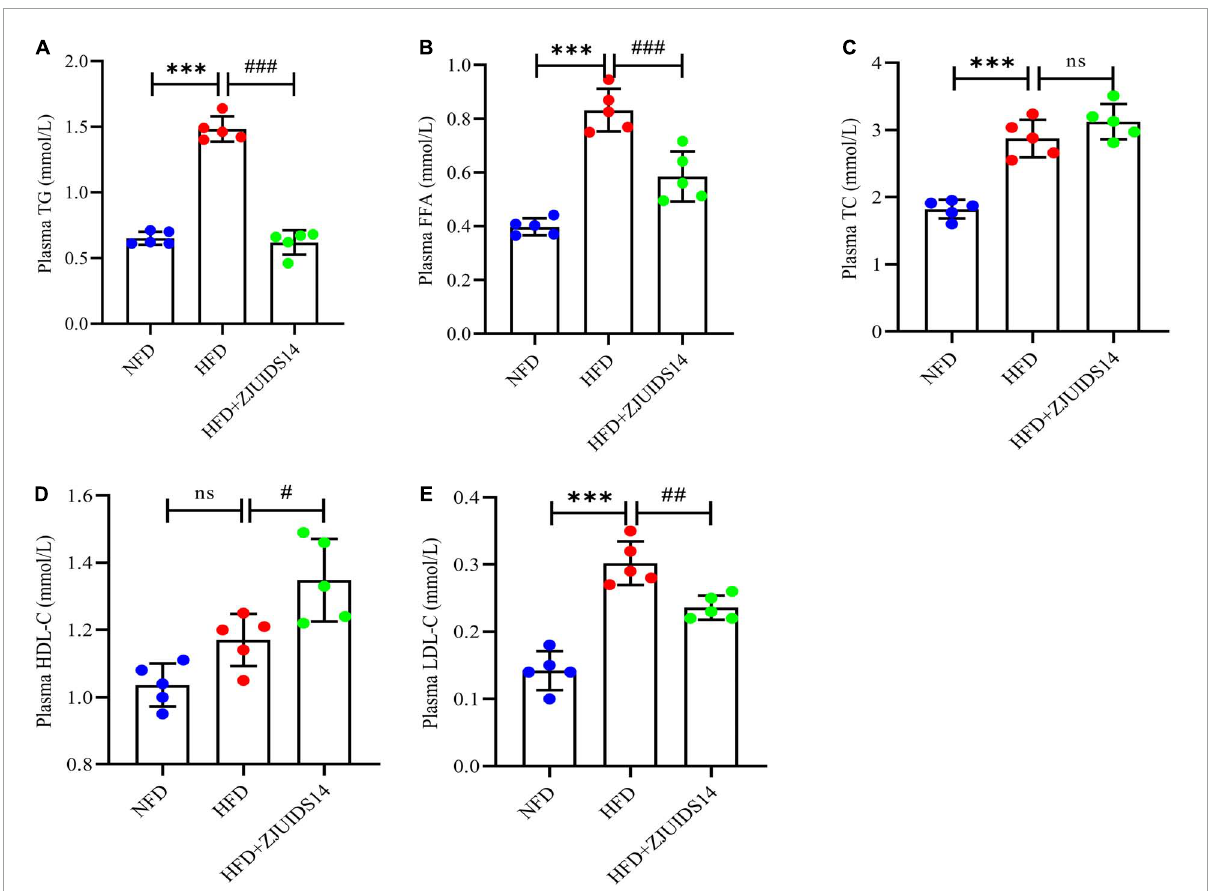
FIGURE3 Lactobacillus plantarum ZJUIDS14 administration reduced dyslipidemia in HFD fed mice. (A) Plasma TG; (B) plasma FFA; (C) plasma TC; (D) plasma HDL-C; (E) plasma LDL-C. ∗∗∗ P < 0.001 vs NFD group; # P < 0.05, ## P < 0.01, ### P < 0.001 vs HFD group. ns, not